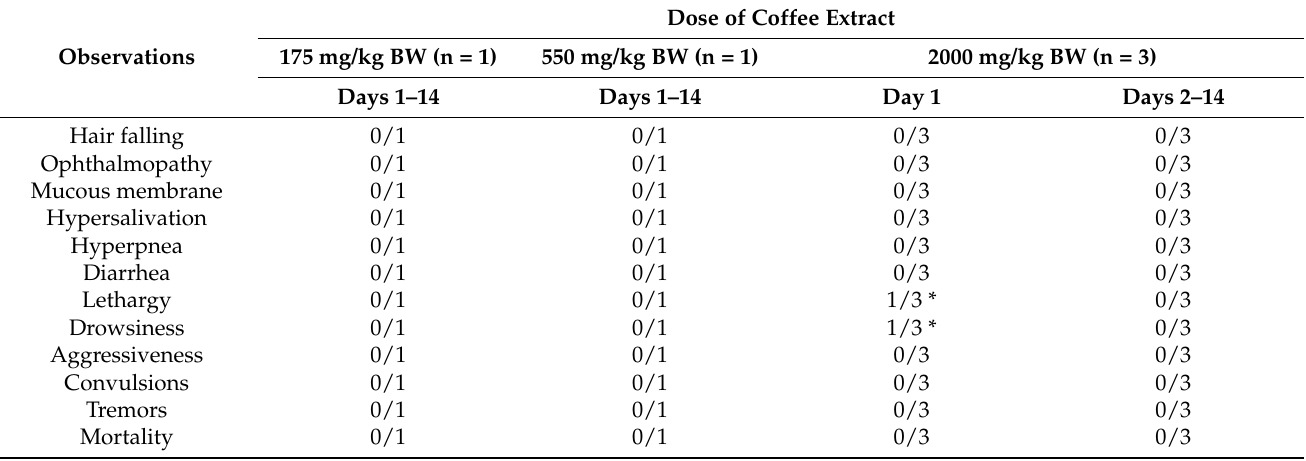
Table 7. Behavioral patterns observed in rats after single oral administration of coffee extract at doses of 175, 550 and 2000 mg/kg BW. Signs of lethargy and drowsiness were observed after 1 h of administering doses of the coffee extract.